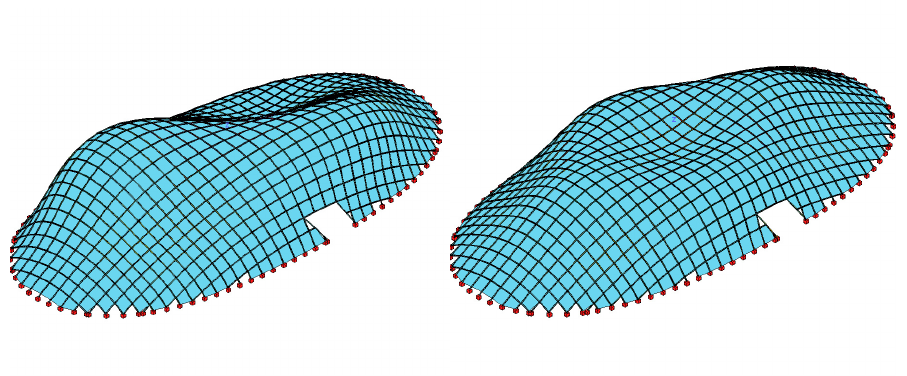
Figure 9: Shell imperfection forms (© Werner Sobek